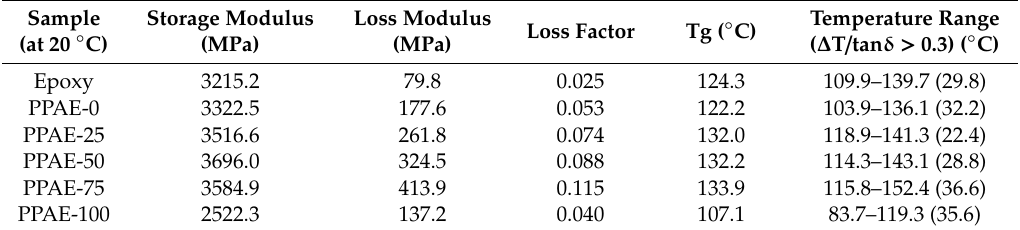
Table 1. Influence of di ff erent PZT content on damping behavior of PPAEs from 0–160 ◦